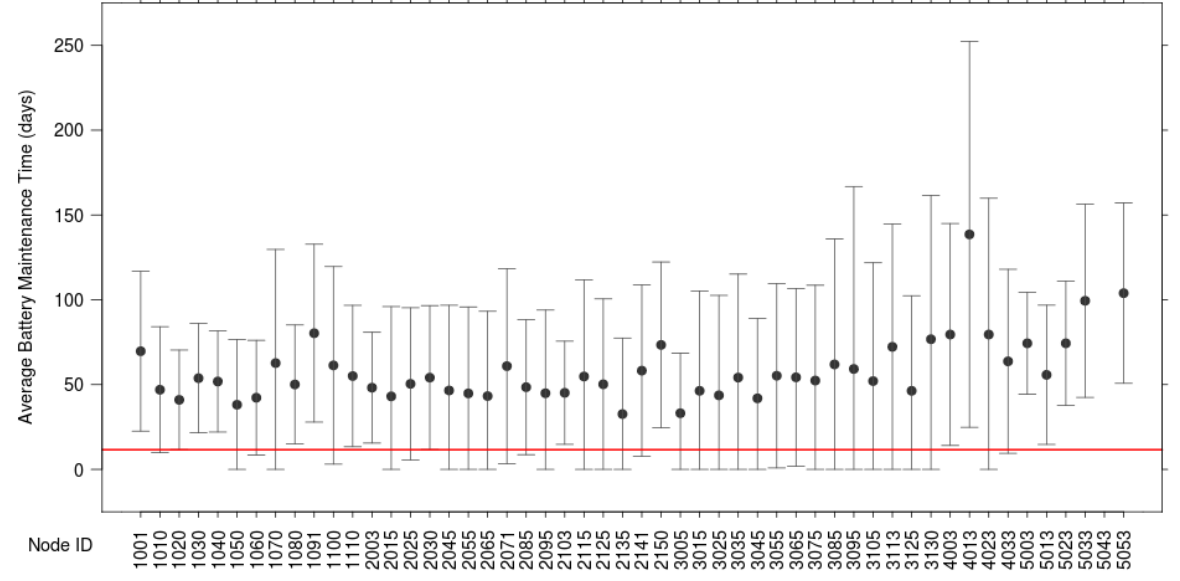
Figure 17. Average and standard deviation of time between battery changes for each node. The red line is the average time between network field visits for battery maintenance.